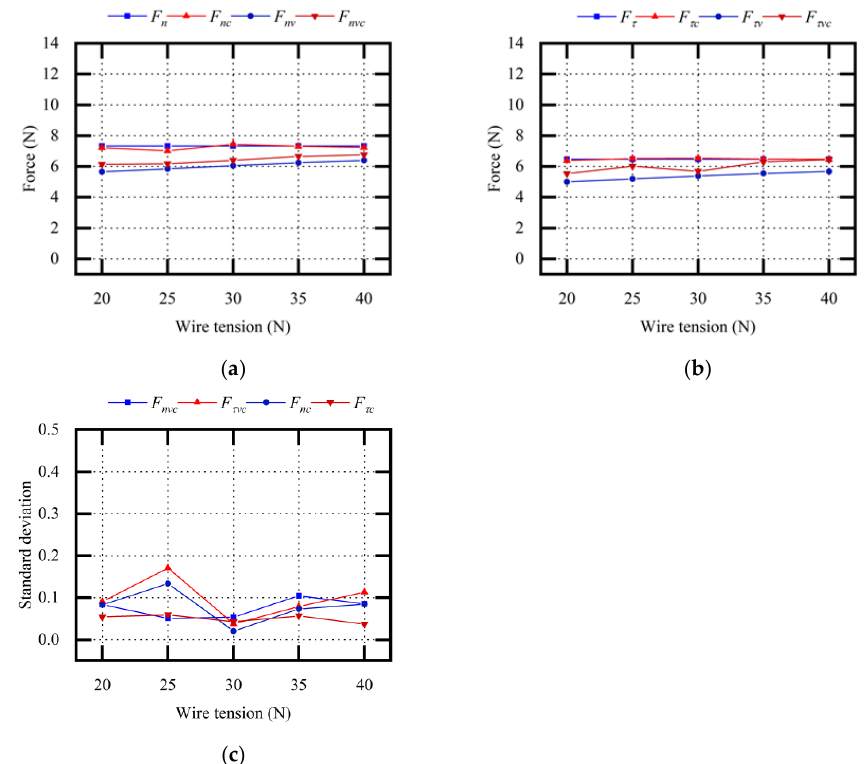
Figure 11. Comparative analysis of sawing force (variable F ): ( a ) normal sawing force; ( b ) tangential sawing force; ( c ) standard deviation σ 1 of experimental values.